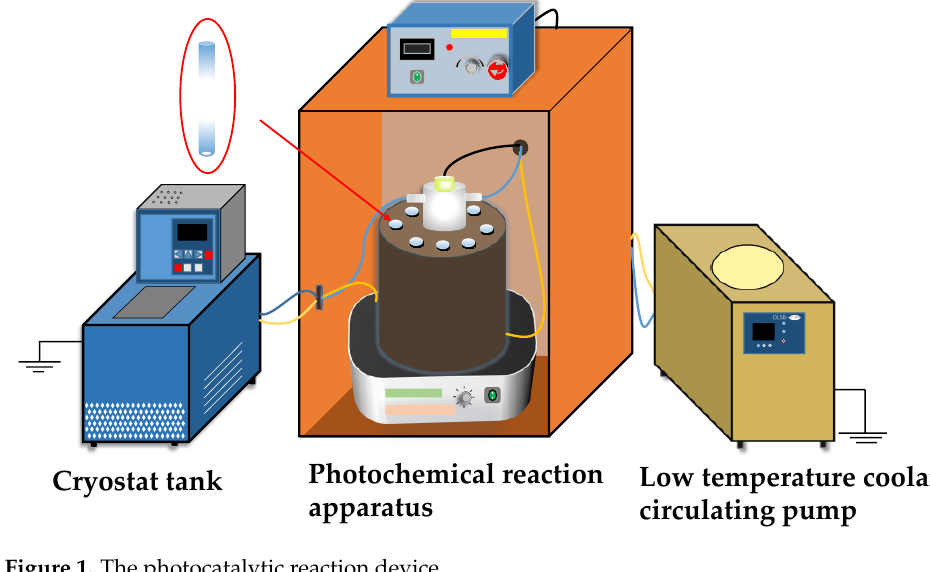
Figure 1. The photocatalytic reaction